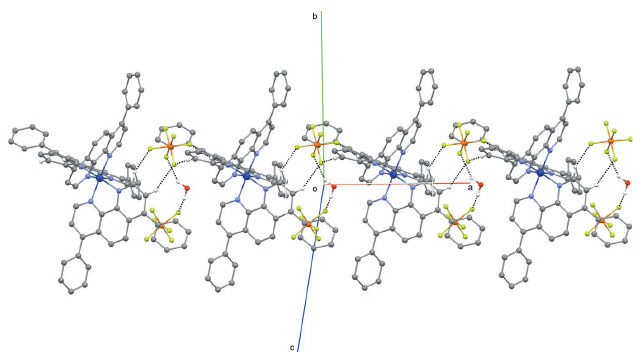
Figure 4 A view of the crystal packing showing C—H (cid:2)(cid:2)(cid:2) F and O—H (cid:2)(cid:2)(cid:2) F intermolecular hydrogen bonds forming chains along the a axis. For clarity, only the major occupancy component of the disordered PF 6 (cid:3) anion is shown.